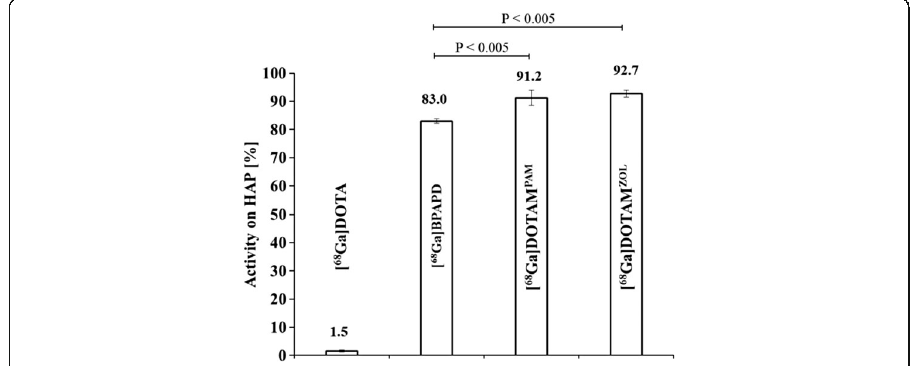
Fig. 1 Adsorption of the three 68 Ga-labelled DOTA-bisphosphonates on 20 mg HAP after 10 min incubation time, compared to [ 68 Ga]DOTA shown in percent of the adsorbed fraction (N =